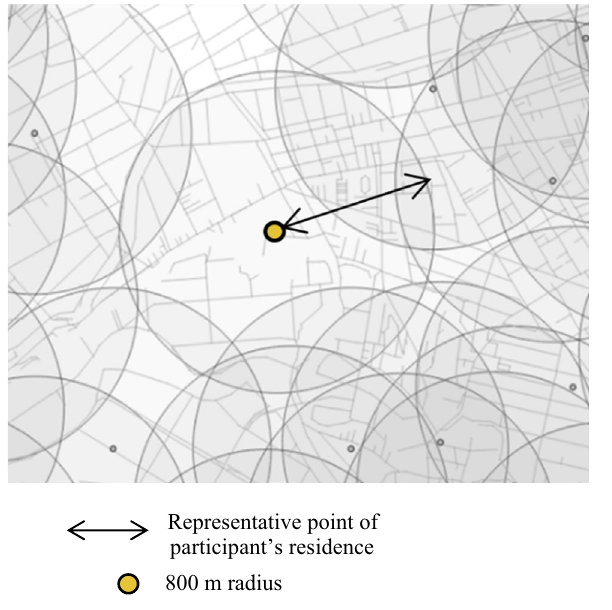
Figure 2. Chocho-aza point data and 800 m